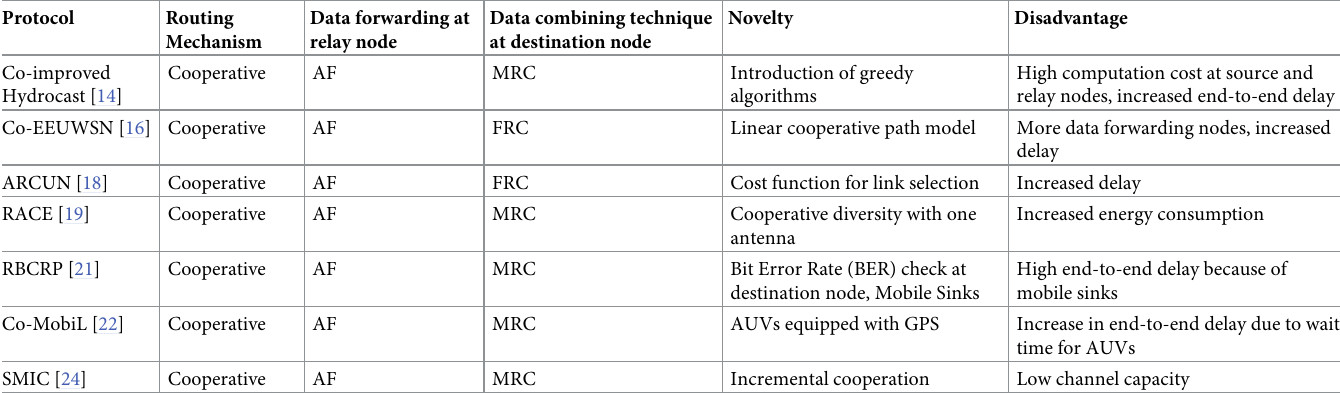
Table 1. Comparison of different routing